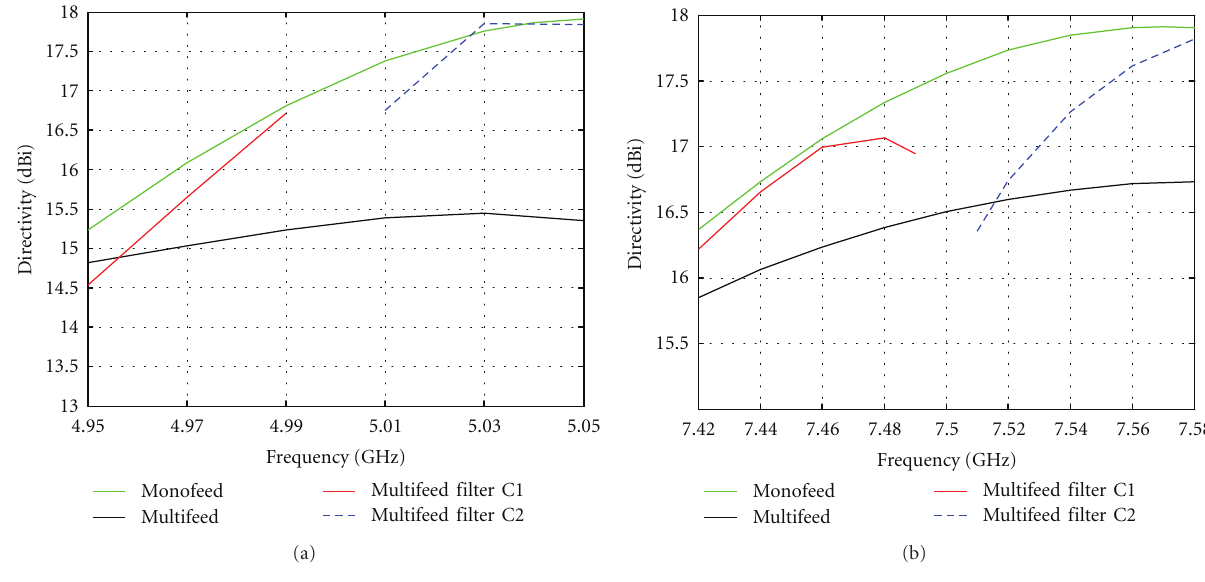
Figure 20: Directivity of the EBG dual-band antenna at f L (a) and f H (b).